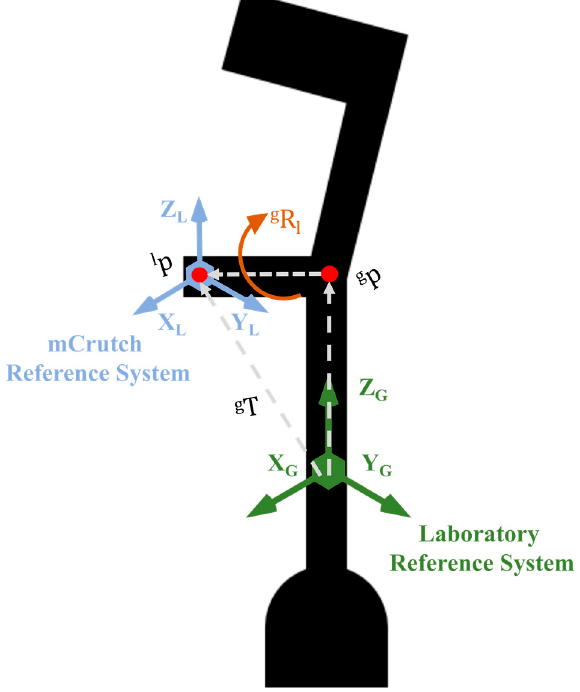
Figure 9. Relationship between the mCrutch reference frame and the laboratory reference